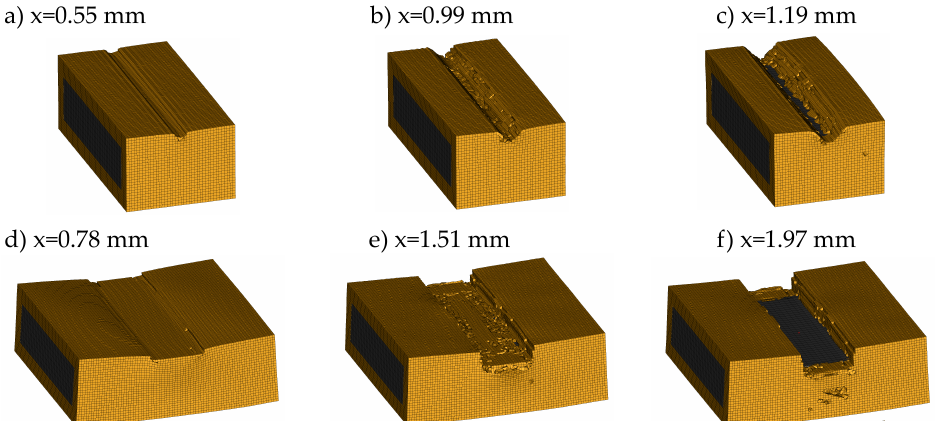
Figure 14. Exemplary sequences from the SHPB simulation on a PA6GF30 insulated busbar in combination with impactor V1 and V4 using the GISSMO strain rate scale factor: ( a – c ) show impactor V1 and ( d – f ) show impactor